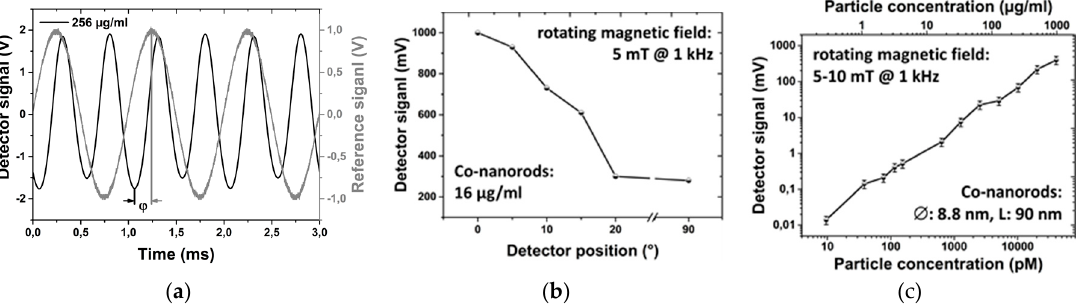
Figure 2. ( a ) Frequency-doubled phase lag detector signal and reference coil signal; Detector signal amplitude for different ( b ) detector positions at adjusted gains and ( c ) nanoparticle concentrations.